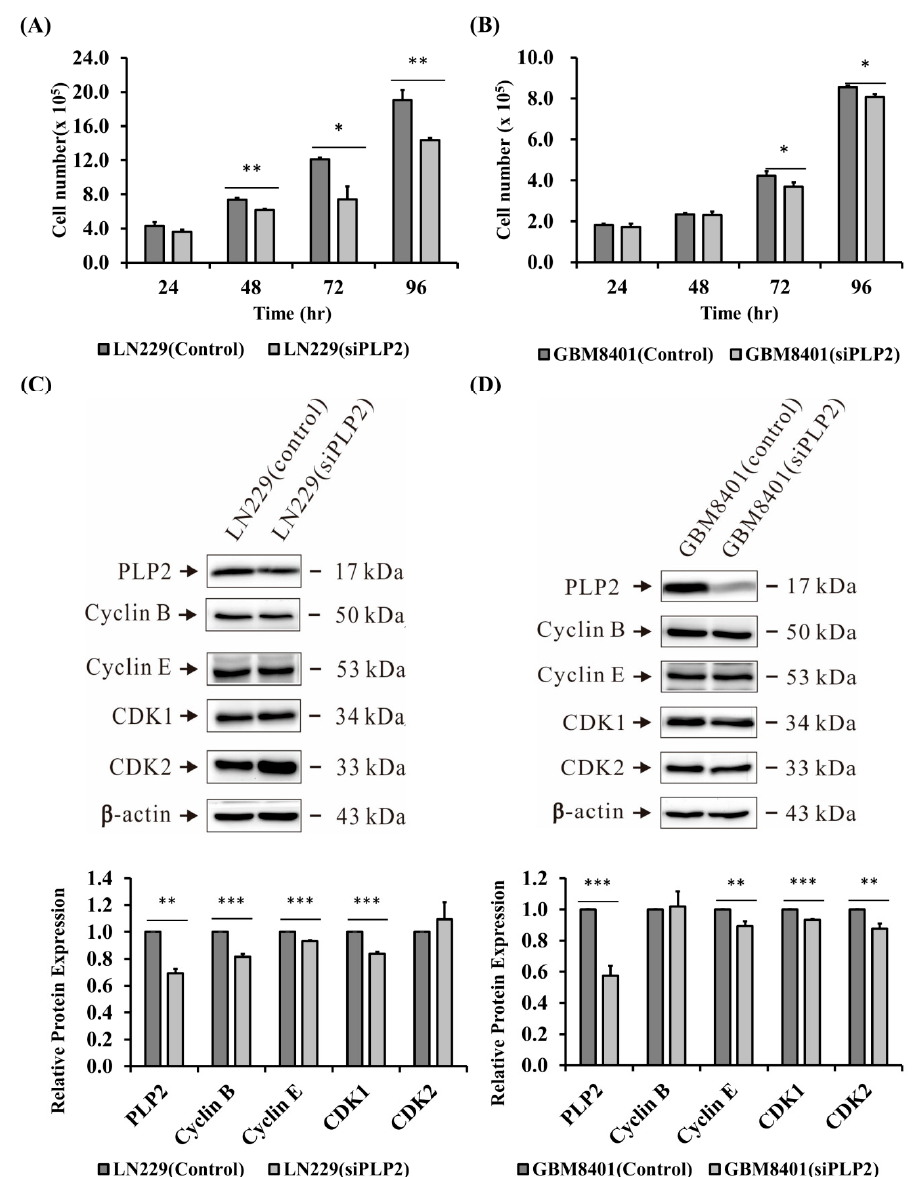
Figure 5. Analysis of ( A ) LN229 and ( B ) GBM8401 glioma cells proliferative ability after using small interfering RNA (siPLP2) to knockdown PLP2 expression. (* p < 0.05; ** p < 0.01); Using western-blot analysis to detect the cell-cycle checkpoints expression in ( C ) LN229 and ( D ) GBM8401 glioma cell lines after siPLP2 administration (** p < 0.01; *** p < 0.001).